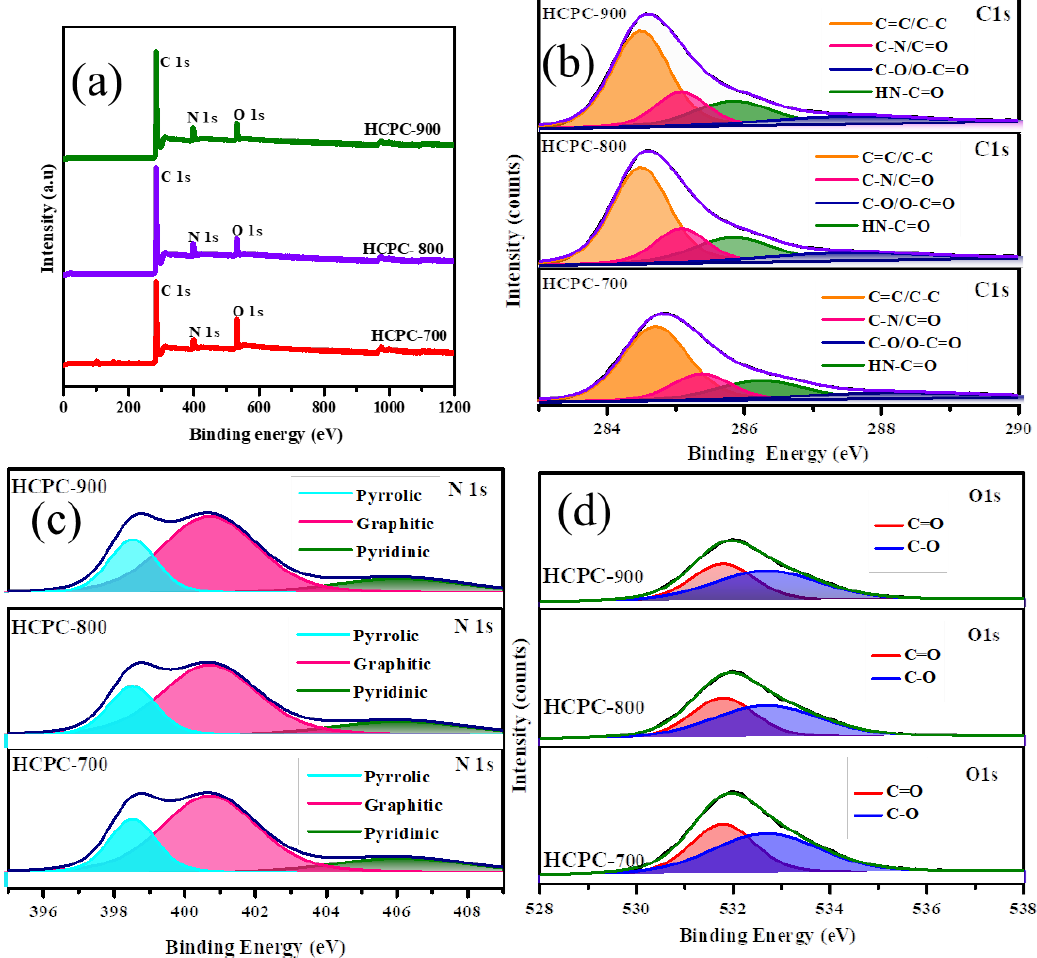
Figure 3. ( a ) XPS spectra and ( b – d ) C1s, N1s and O1s spectra of HCPCs.